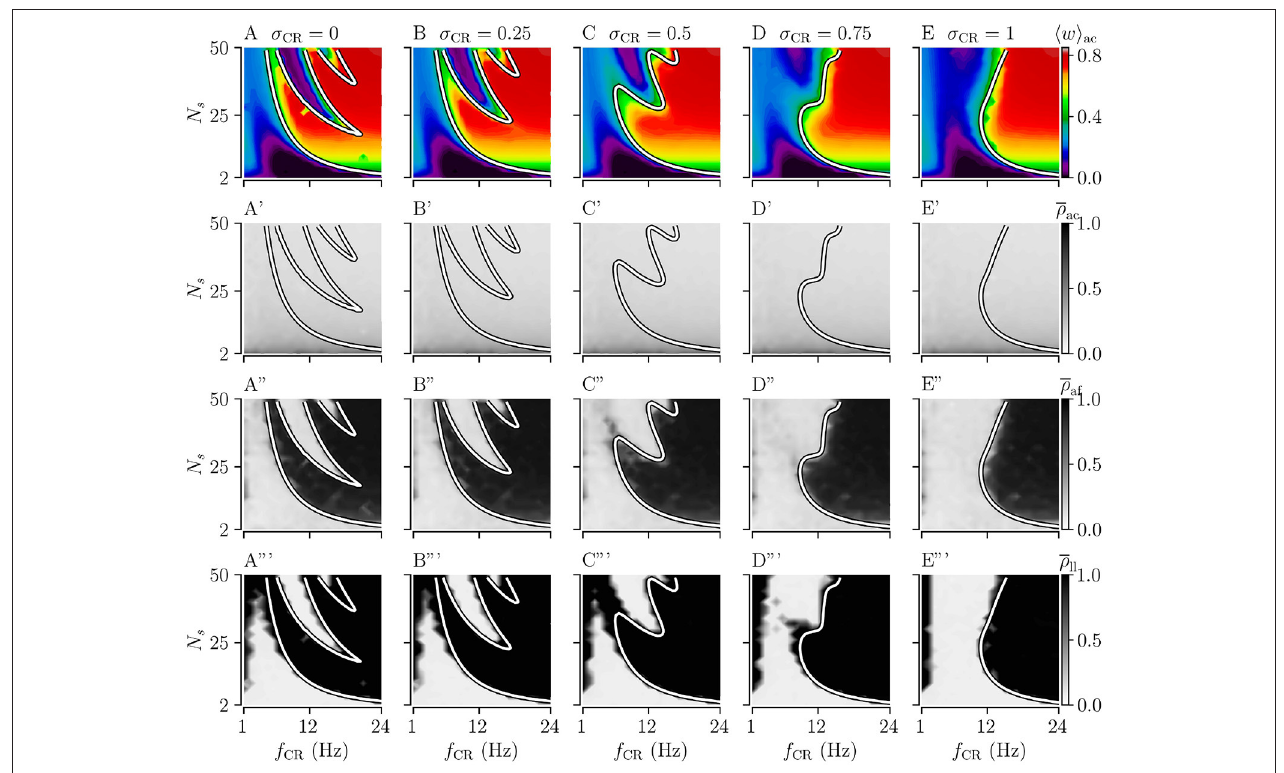
FIGURE 4 | Acute, acute after-, and long-lasting effects of Shuffled Noisy CR (SNCR) for different values of the stimulus jitter, σ CR , for strong stimulation as a function of the stimulation frequency and the number of stimulation sites. (A–E) Acute mean synaptic weights, h w i ac ; (A’–E’) The acute Kuramoto order parameter, ρ ac , time-averaged over the last 10 s of the stimulation; (A”–E”) The acute after-effect of stimulation on synchronization as measured by the Kuramoto order parameter, ρ af , time-averaged over an interval of 10 s right after cessation of the stimulation; (A”’–E”’) Long-lasting effects of stimulation as quantified by the Kuramoto order parameter, ρ ll , time-averaged over a 10 s interval 1,000 s after cessation of stimulation. Parameters: The stimulation duration was set as T stim = 1,000 s and A stim =